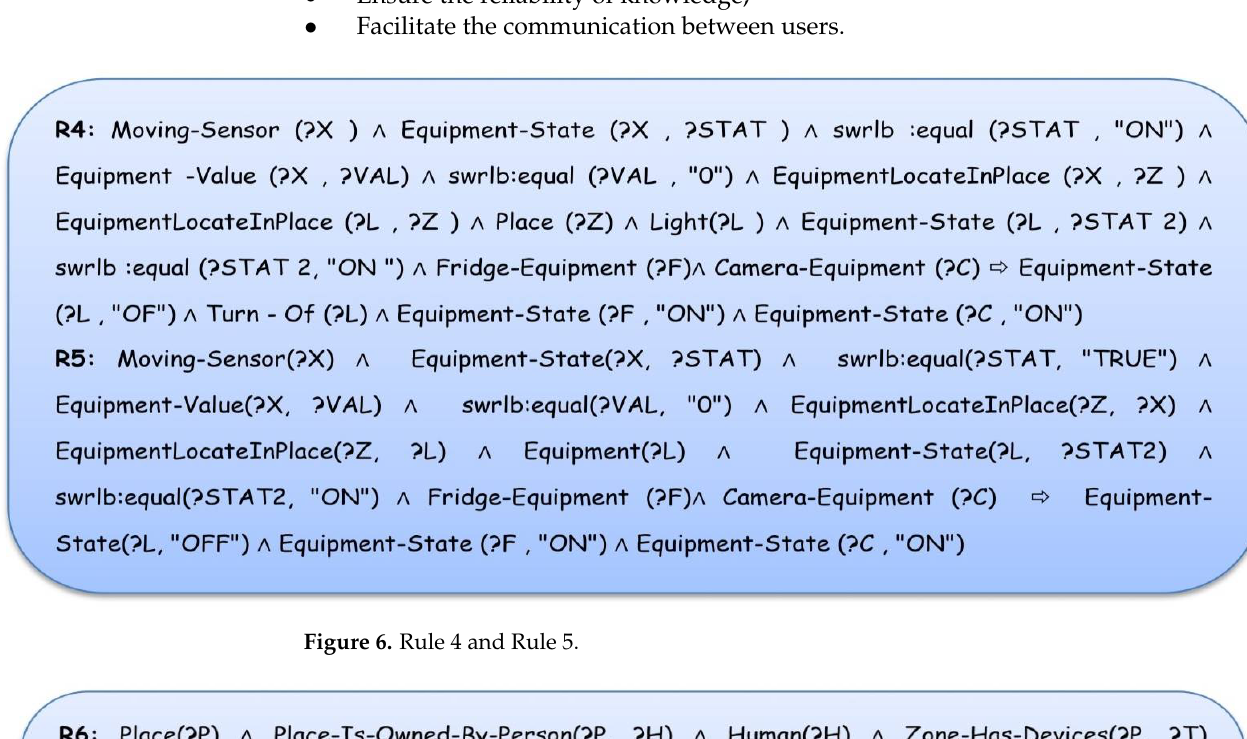
Figure 6. Rule 4 and Rule 5.